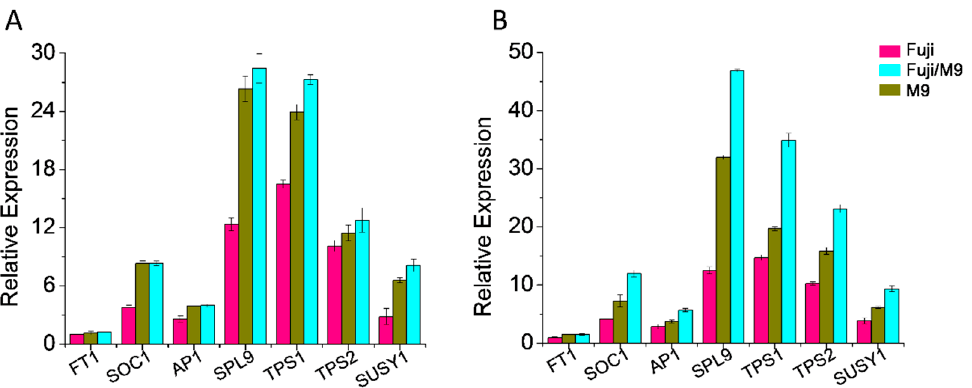
Figure 9. qRT-PCR analysis of relative expression levels of flowering related genes in leaves and flower buds in Fuji, Fuji/M9, and M9: ( A ) leaves, ( B ) buds.